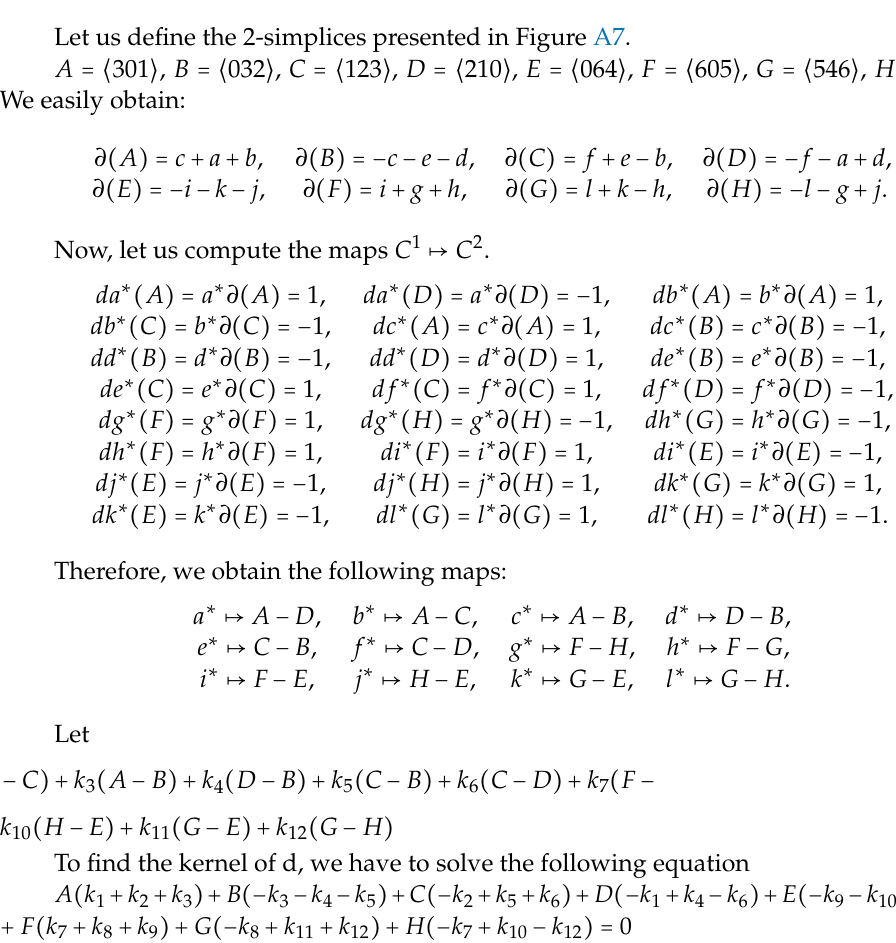
Figure A7. Homeomorphic representation of the TI read by CC at